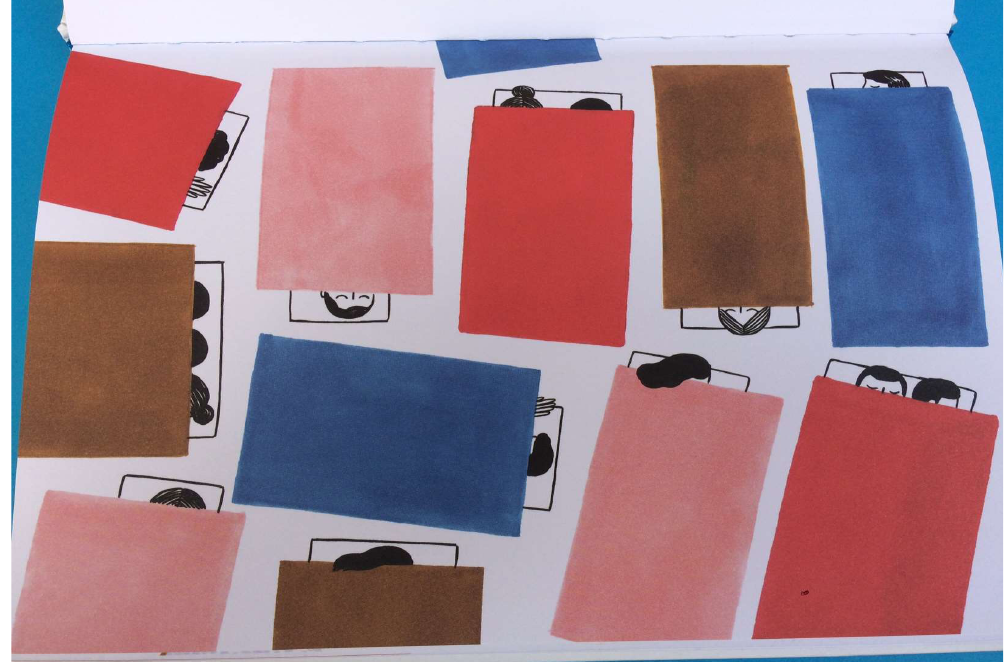
Figure 1. Migrants sleeping in a refugee camp, by: PlanètMigrants , cit. p.